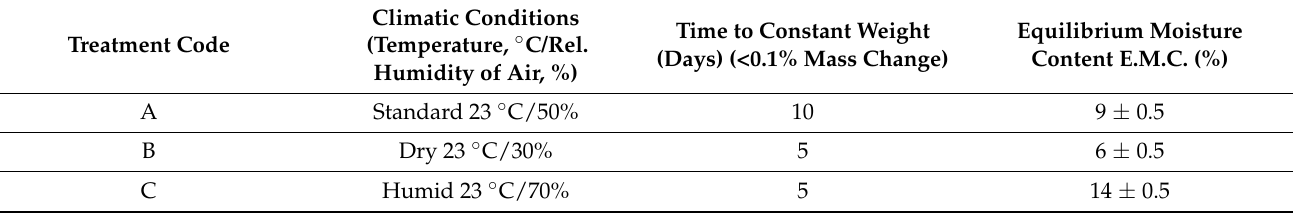
Table 3. Samples conditioning parameters.